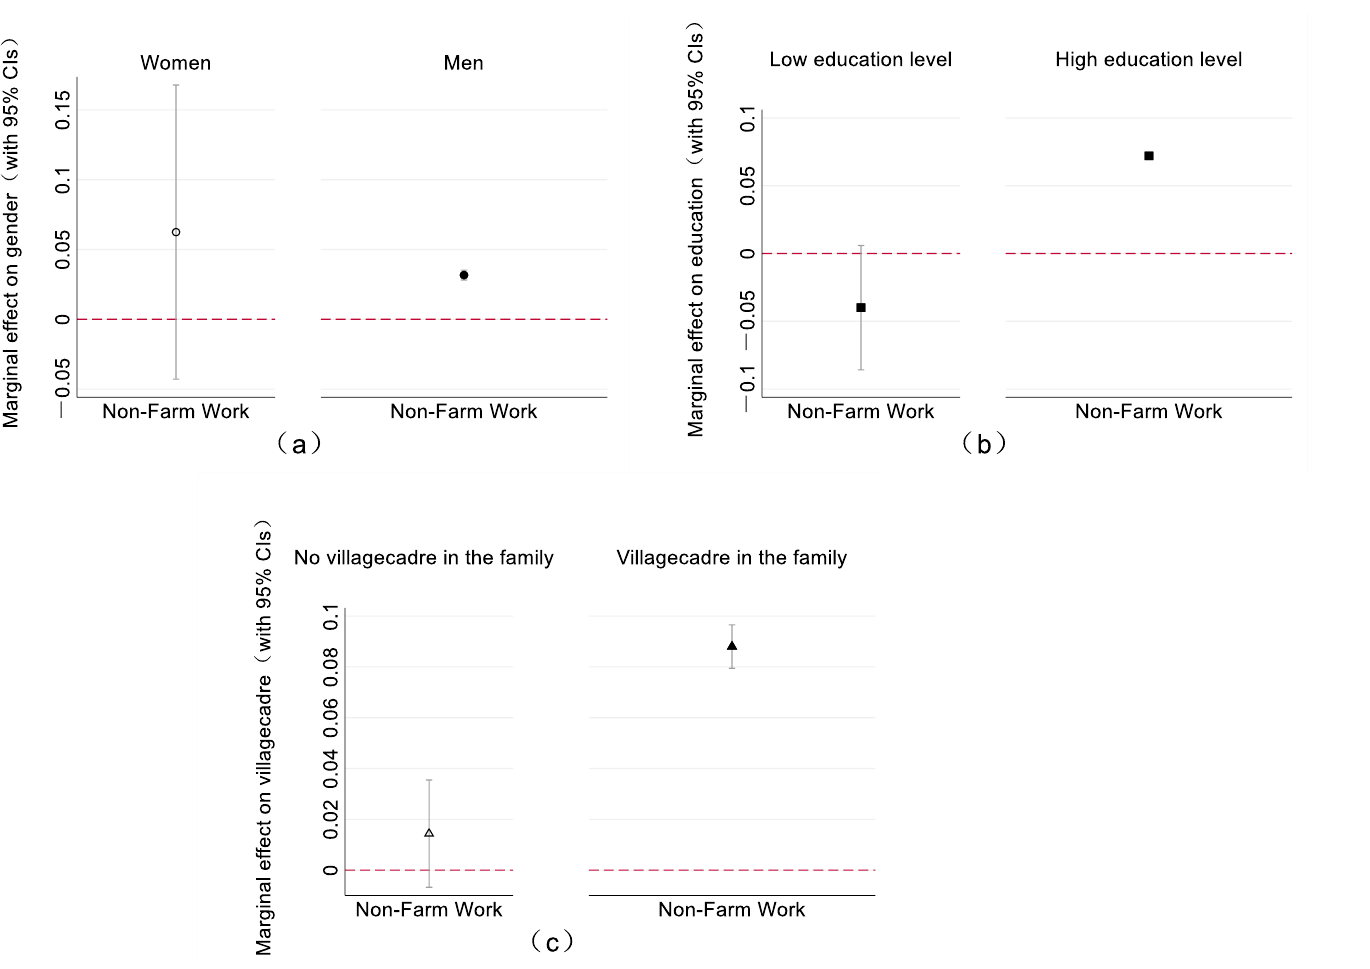
Figure 4. Marginal Effects by Heterogeneity Groups. Note: Hollow circle and hollow triangle indicate that the regression coefficients are not significant at the 10% significance level. Table 6. Heterogeneity analysis: Age.